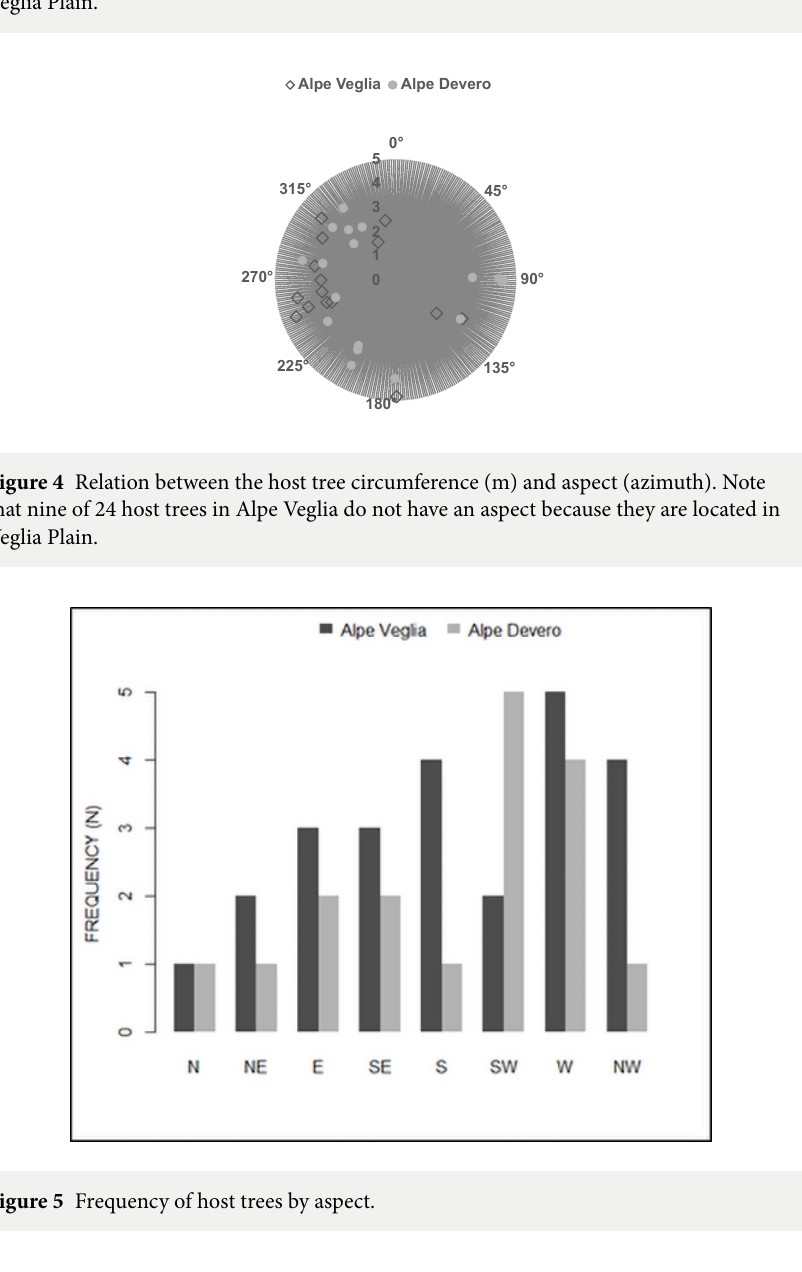
Figure 3 Relation between the elevation (m above sea level) and aspect (azimuth). Note that nine of 24 host trees in Alpe Veglia do not have an aspect because they are located in Veglia Plain.